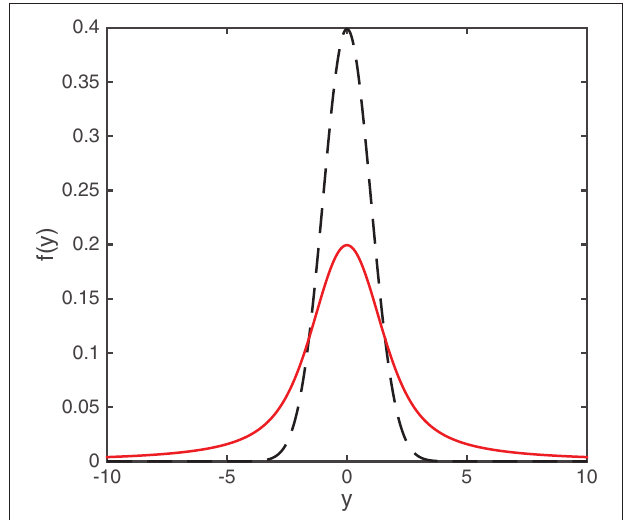
FIGURE 1 | Standard Gaussian probability distribution with zero mean and standard deviation of one (dashed black) and the derived likelihood distribution (solid red) as described in the